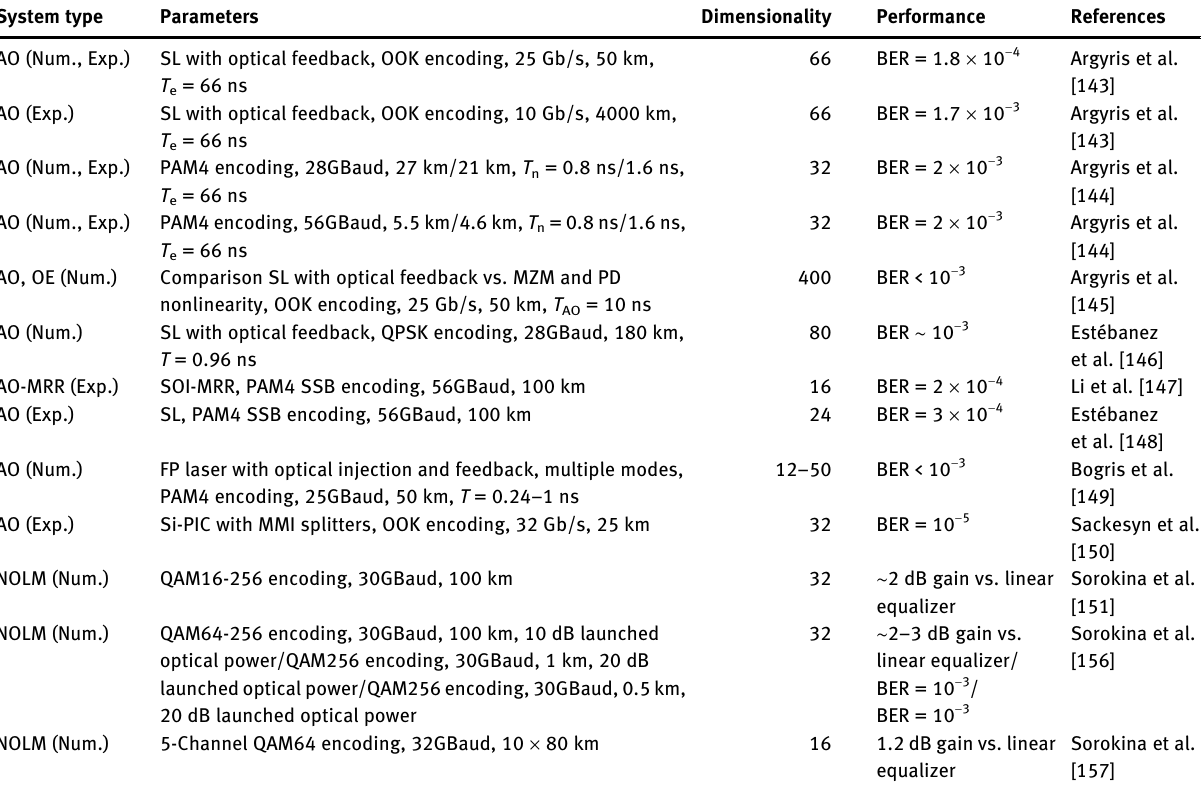
Table  : Photonic neuromorphicsystemsbasedonRC appliedonthe signalrecovery. T n : timedelayin numerical simulation. T e : timedelayin experimental implementation. T AO : time delay in AO system. NOLM: nonlinear optical loop mirror. System